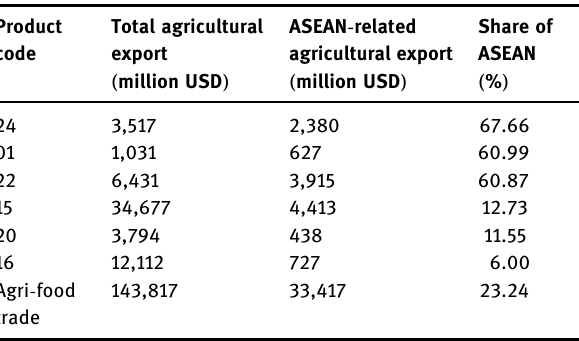
Table 3: The TOP 3 most and least traded product groups at ASEAN level,